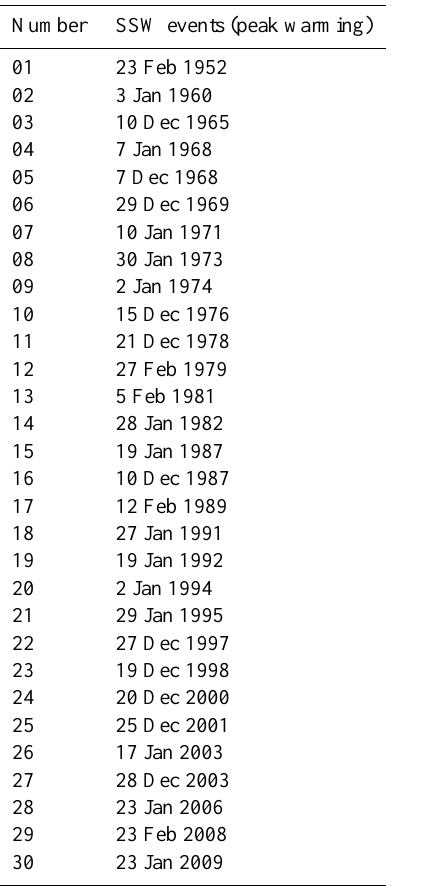
Table 1. SSW events of 1952–2009 identified using NCEP/NCAR reanalysis data. The definition used to identify SSW events is de- scribed in Sect. 4.